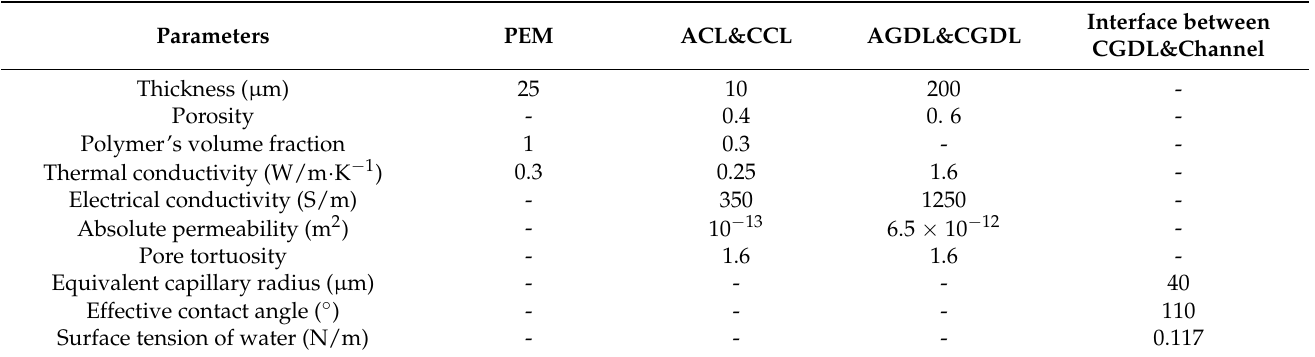
Table 2. Physical parameters of the model.